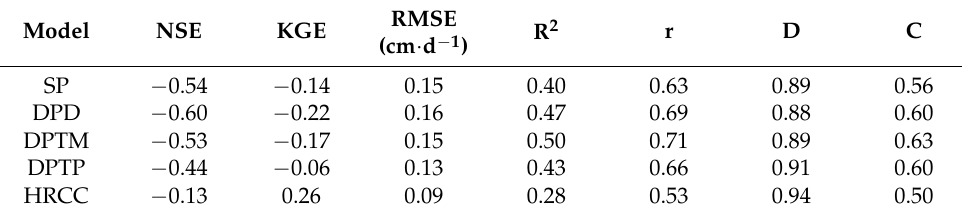
Table 9. Statistics of the model adjustments for the ETa measured in the Pasture area.